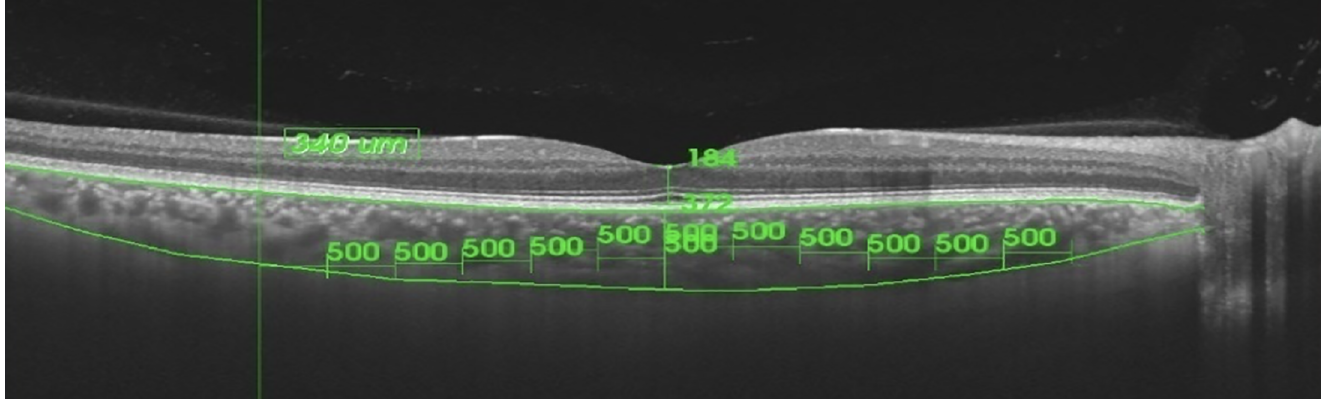
Fig 1. OCT scan showing choroidal thickness measurement at 13 different